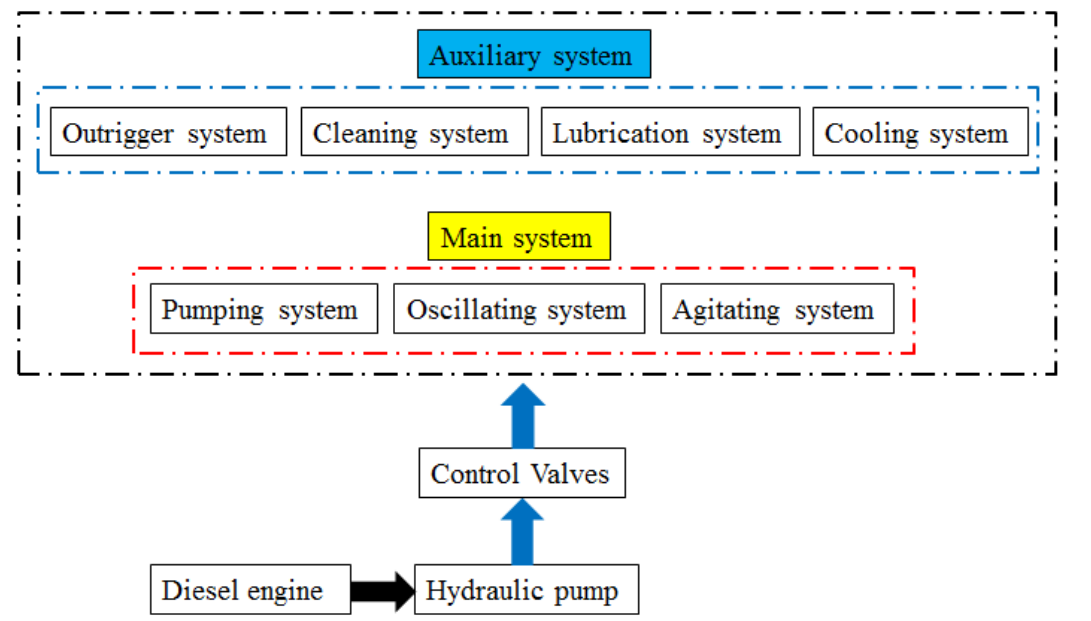
Figure 3. Structure diagram of trailer concrete pump.